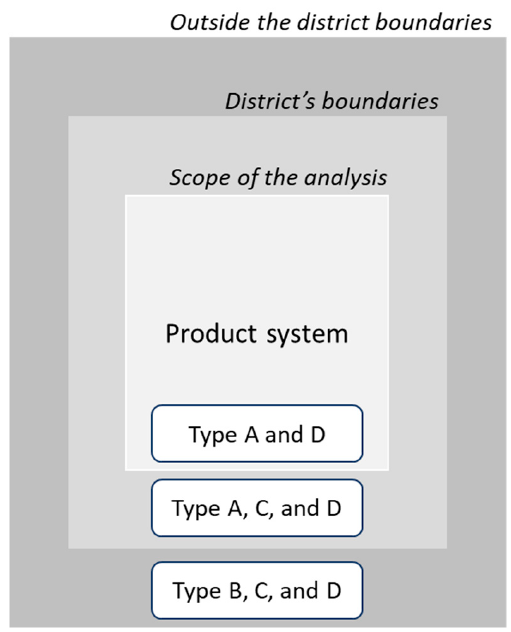
Figure 2. Sphere of influence of types of approaches.